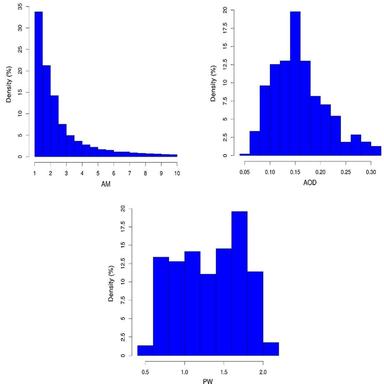
Annual histograms of AM, AOD and PW for Granada.